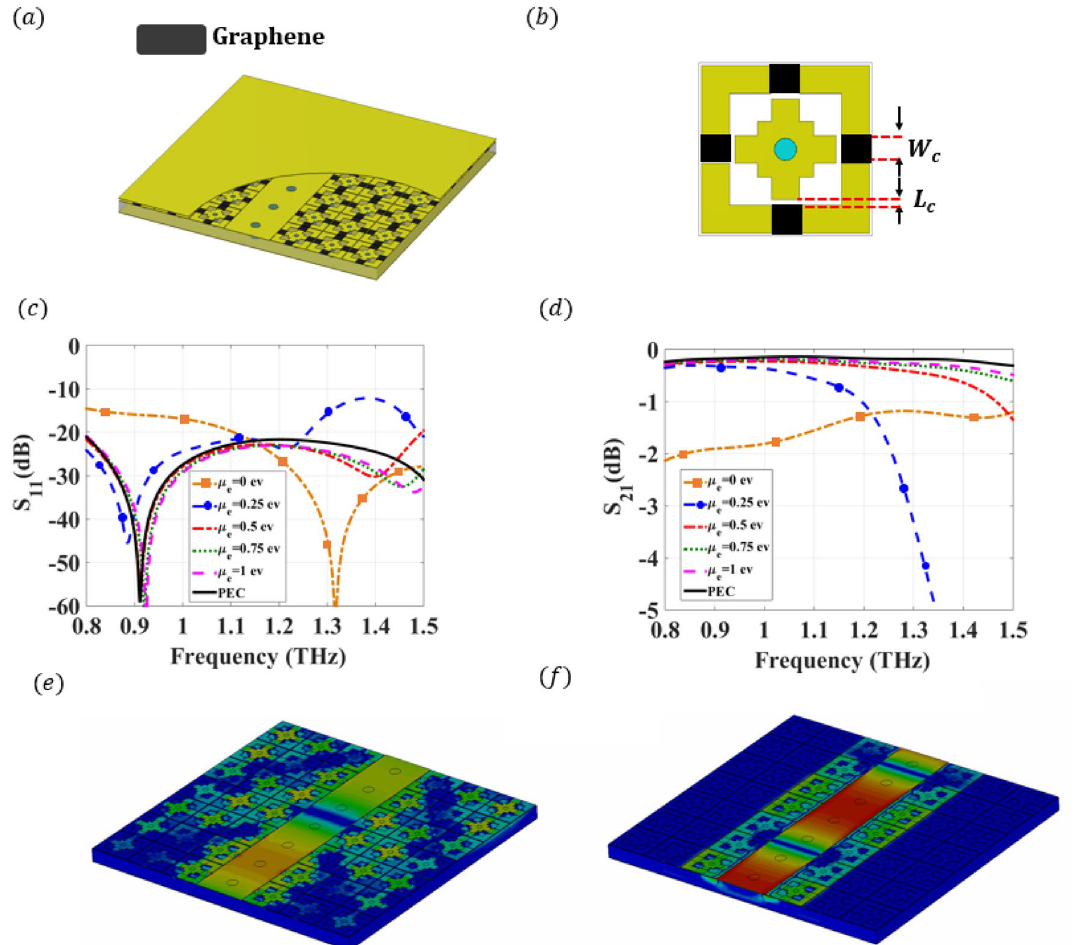
Figure 4. 3-D view of the proposed graphene-based terahertz PRGW transmission line and simulated performance using full wave analysis. ( a ) 3-D view of the reconfigurable PRGW line surrounded by a graphene- based unit cell. ( b ) 2-D configuration of the Graphene unit cell. The openings are introduced in the unit cell to allow placing the graphene, where the opening dimensions are set as W c = 5 μm and L c = 1 μm. ( c ) Simulated S 11 of the proposed reconfigurable graphene-based terahertz PRGW transmission line for altering the 0 ev to µ 1 ev. ( d ) Simulated S 21 of the proposed reconfigurable graphene- chemical potentials from µ c c = = 0 ev to µ 1 ev. ( e ) based terahertz PRGW transmission line for altering the chemical potentials from µ c c = = 0 ev. ( f ) Electric field distribution for the Electric field distribution for the propagating mode at 1 THz for µ c = 1 propagating mode at 1 THz for µ c =